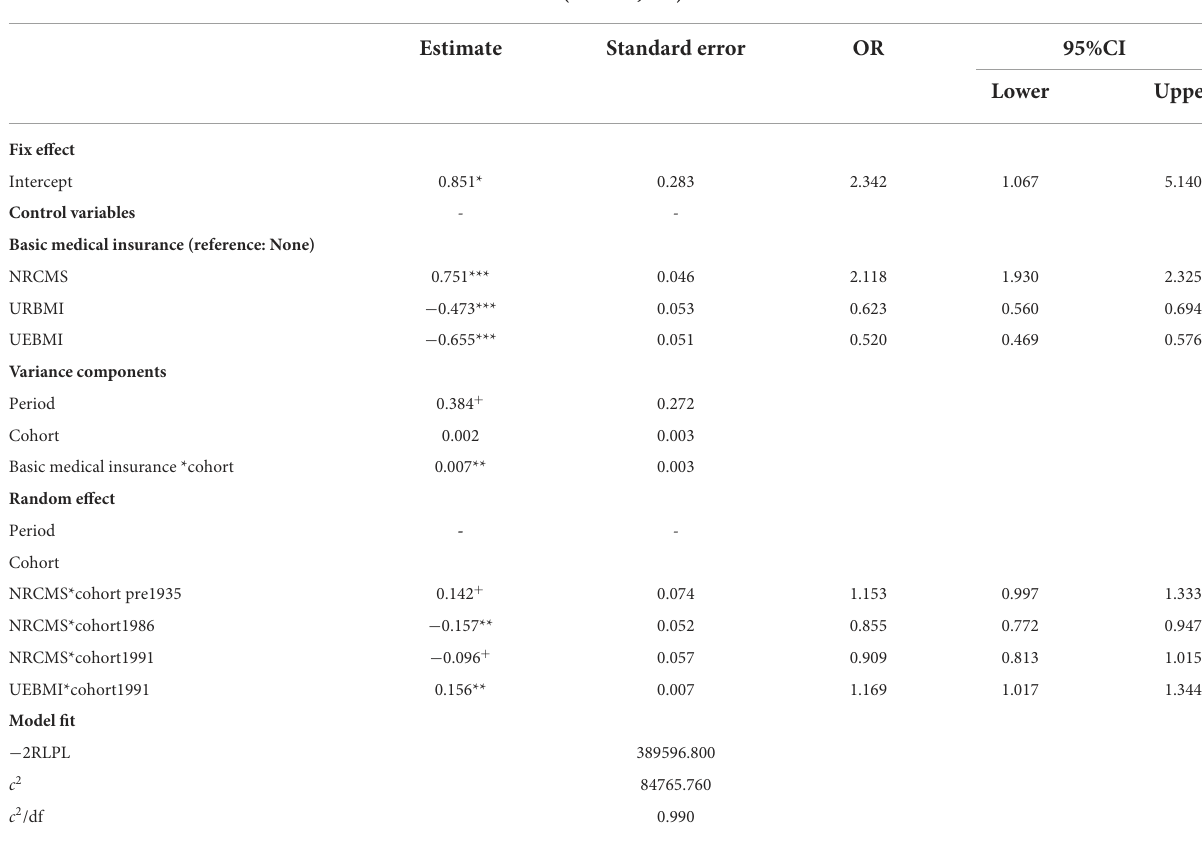
TABLE 4 The effect of basic medical insurance participation on variation of primary care with